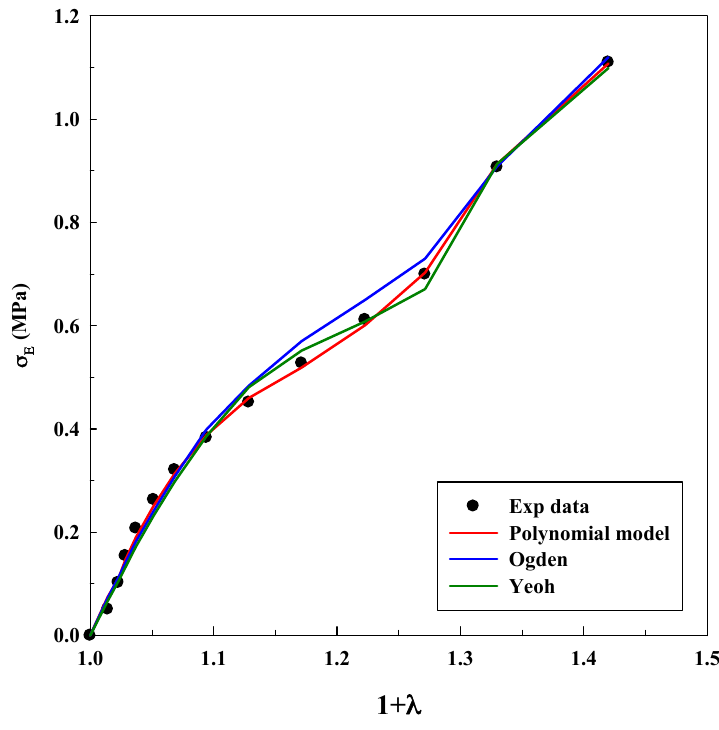
Figure 4. Models fitting of stress–elongation for the system A/G 50/50% v / v at 2% w / w .